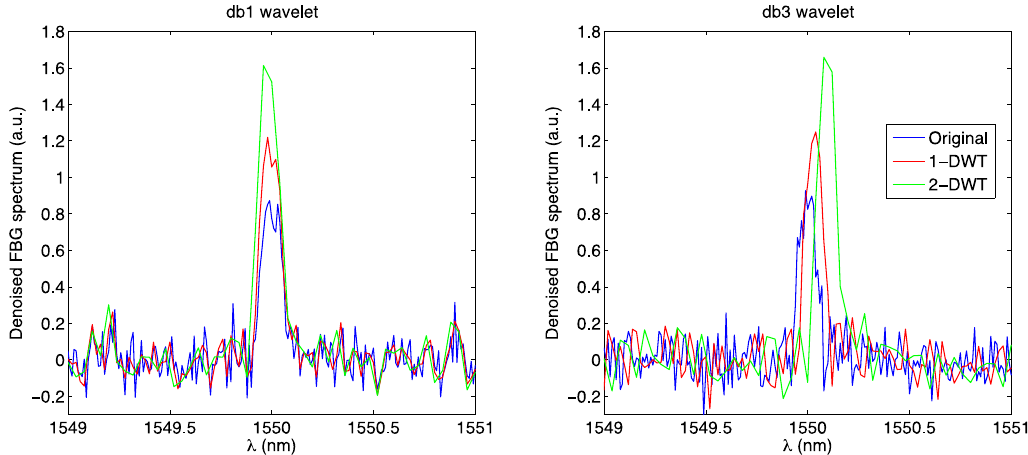
Figure 15. DWT denoising of an FBG spectrum. The original noisy spectrum (blue) is filtered through a DWT → thresholding → IDWT cycle once (red) and twice (green) for denoising. Daubechies wavelets db1 ( left ) and db3 ( right ) have been used.